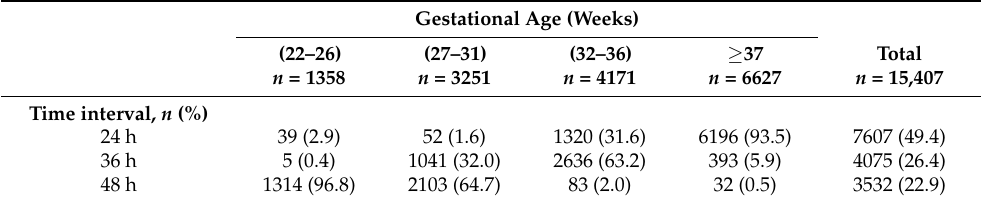
Table 1. Time interval between unit doses at first gentamicin administration by gestational age during the first week of life.